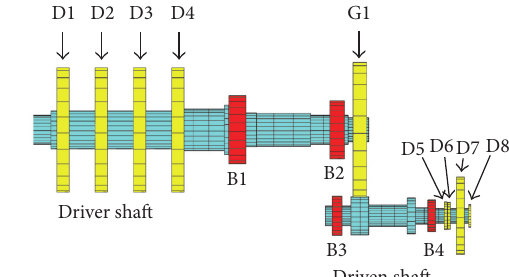
Table 1: Physical parameters of five gears.